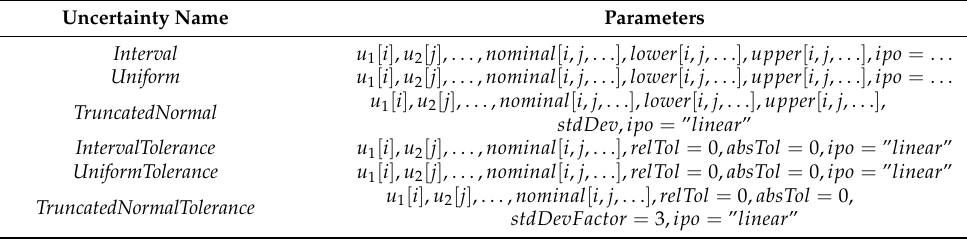
Table 3. Examples for the proposal to define uncertainty descriptions with generic and tolerance parameterizations of array parameters. u 1 [ i ] , u 2 [ j ] , . . . are the vectors of the independent variables, nominal [ i , j , . . . ] is the array of the nominal values with respect to u 1 [ i ] , u 2 [ j ] , . . .. The corresponding array limits are defined with lower [ i , j , . . . ] , upper [ i , j , . . . ] arrays. ipo is the interpolation method to compute the dependent variable y from the independent variables and the nominal array. It is outside the scope of this article to propose a set of standard interpolation methods from the many available algorithms, besides linear interpolation. Default values are given with “=...”, such as “ relTol = 0”. For example, a 2D uncertainty table might be defined by the vectors of the independent variables u 1 = [ 0.1,0.2,0.3,0.4 ] and u 2 = [ 10,20,30 ] , a matrix of size [ 4,3 ] of the nominal values [ 110 120 130;210 220 230;310 320 330;410 420 430 ] (e.g., y = 230 is the nominal value for u 1 = 0.2, u 2 = 30) a matrix of size [ 4,3 ] of the lower limits [ 11 12 13;21 22 23;31 32 33;41 42 43 ] and a matrix of size [ 4,3 ] of the upper limits [ 119 129 139;219 229 239;319 329 339; 419 429 439 ] (e.g., the uncertainty table value of u 1 = 0.2, u 2 = 30 must be in the range [ 23 . . . 239 ]